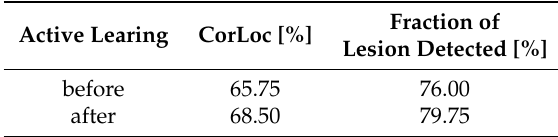
Table 3. Results showing the effect of active learning in SNUBH dataset. Active